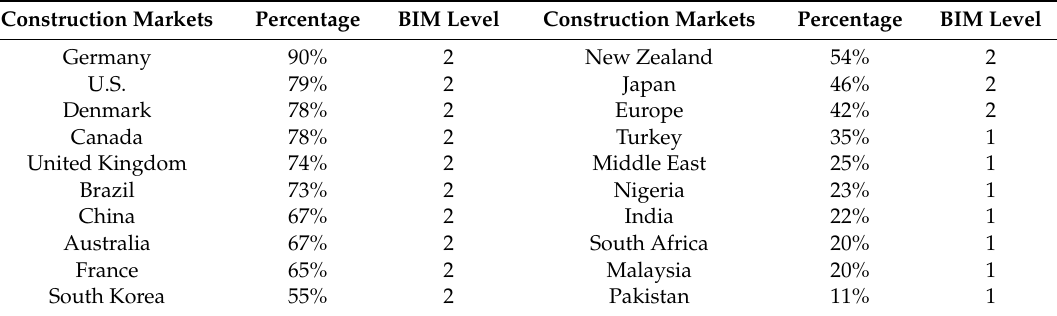
Table 1. Implementation percentages of Building Information Modeling (BIM) in various construction markets data obtained from